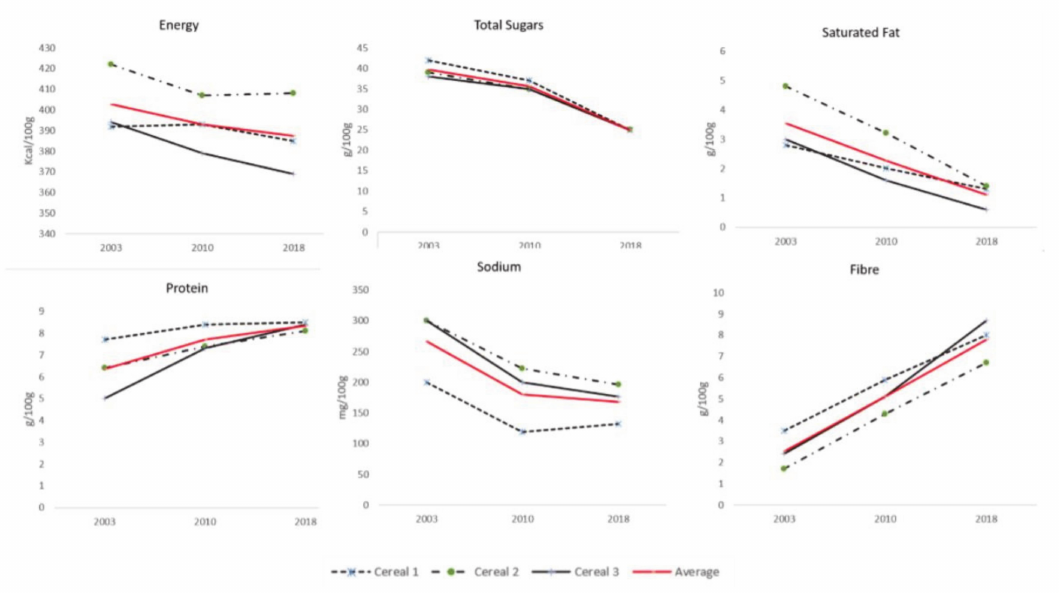
Figure 2. Changes in the nutritional composition of the products studied over the 2003–2018 period.